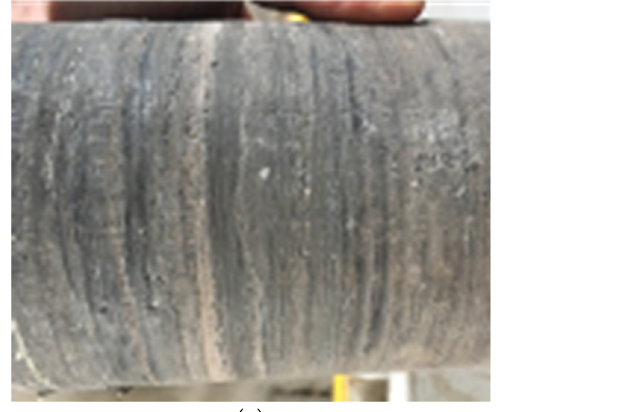
Figure 1. Mineral content of the third submember of the Chang 7 member: ( a ) Mineral content fluctuation diagram; ( b ) clay content fluctuation diagram.